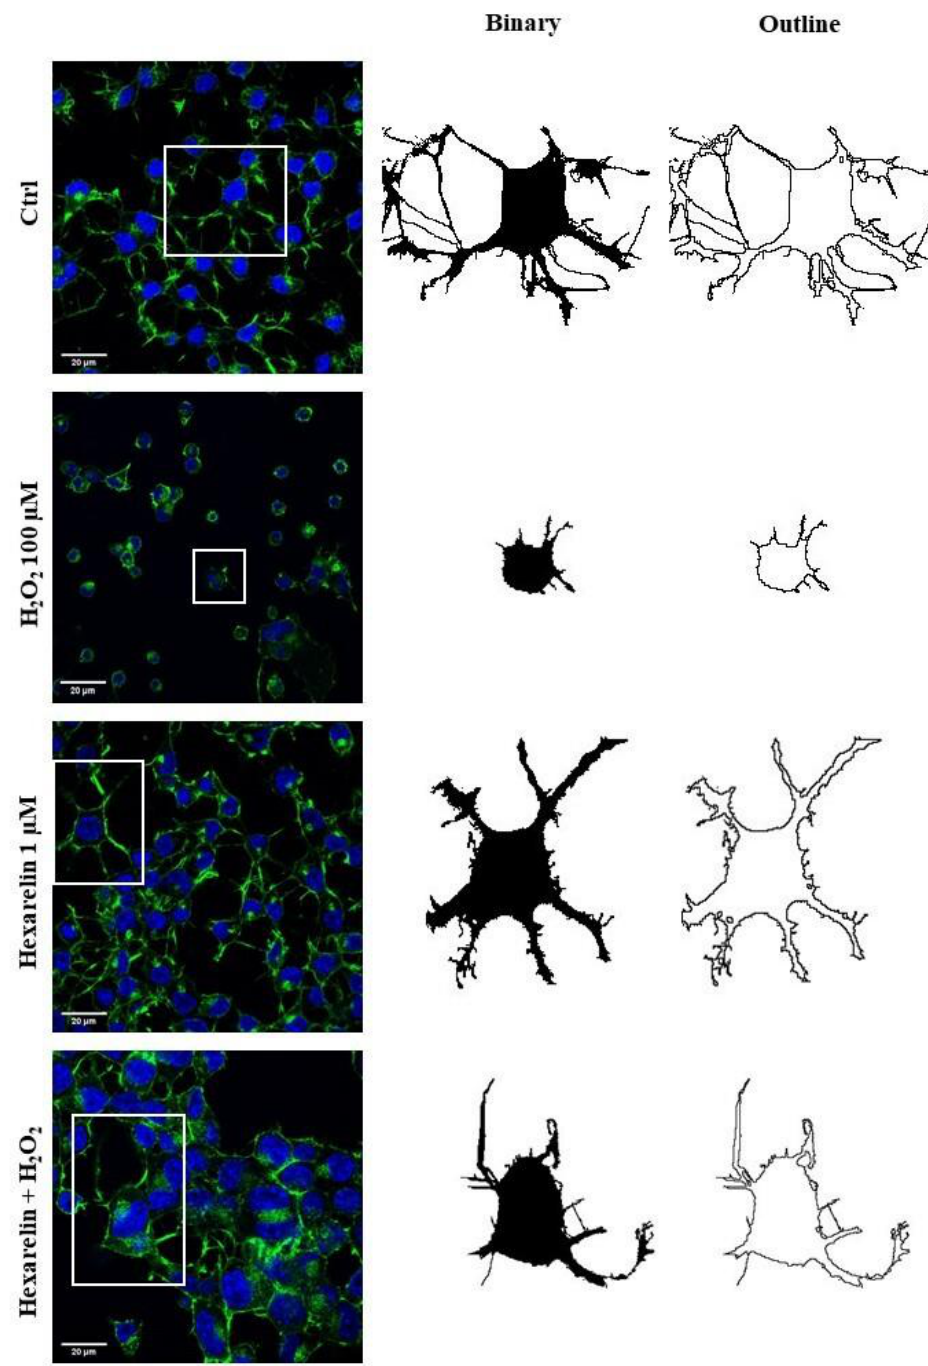
Figure 5. Effects of hexarelin on morphology of Neuro-2A cells stimulated with H 2 O 2 . Representative photomicrographs of Neuro-2A cells incubated for 24 h with or without hexarelin and 100 µ M H 2 O 2 , and examples of cell binarized and outlined. Cells were seeded on poly-D-lysine pre-treated coverslips and, at the end of the treatments, were fixed and stained with phalloidin and DAPI. Images were captured with a confocal laser scan microscope. Scale bar: 20 µm.